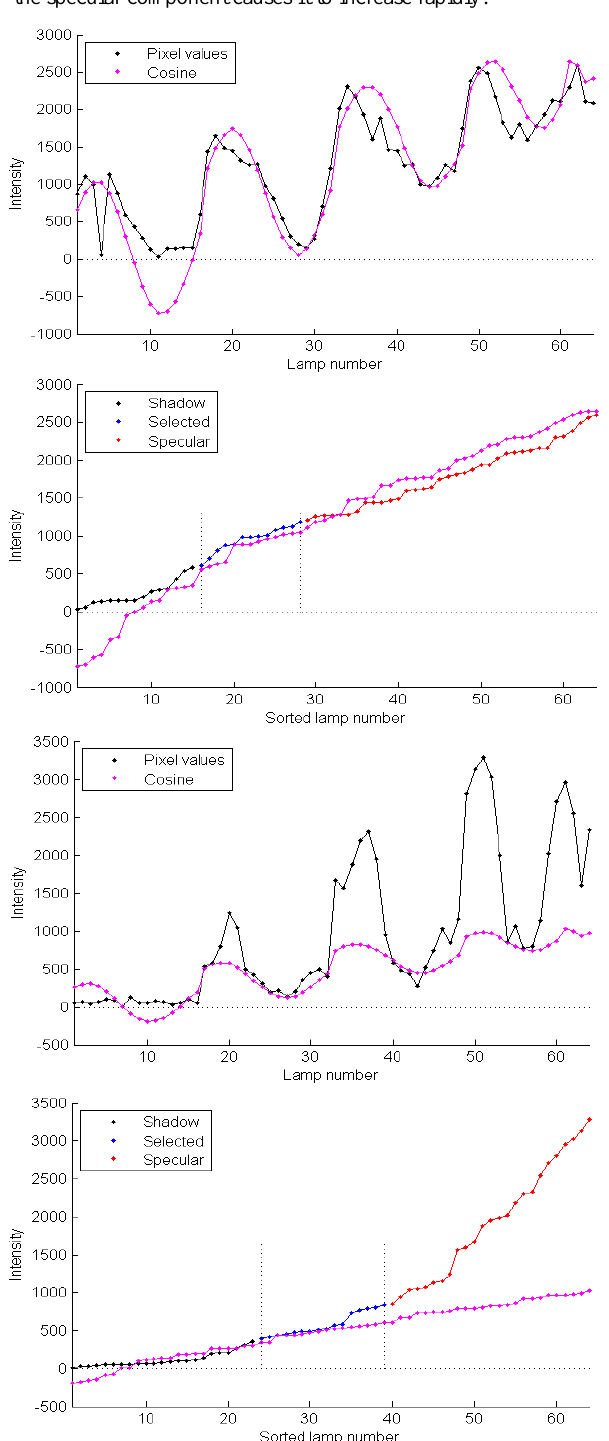
Figure 6. Intensity distributions for one pixel across 64 images for: (top) white ball and (bottom) planar metallic surface. Cosine for a Lambertian surface of same albedo is shown in magenta.